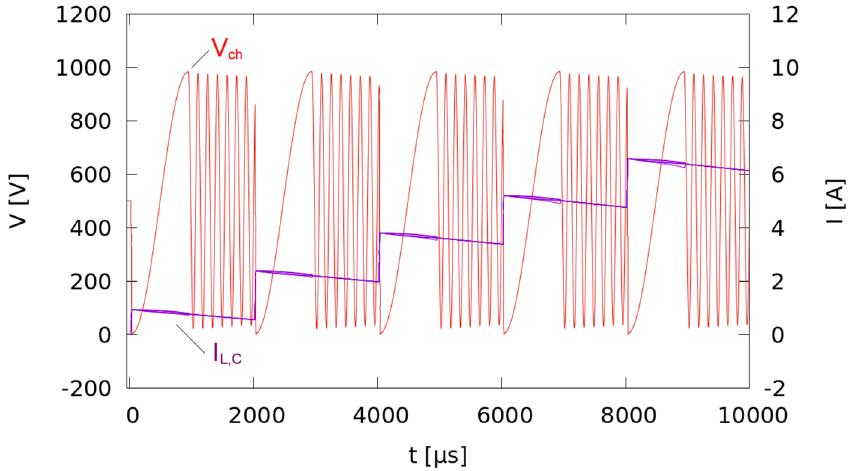
Figure 8. Simulated common-mode currents in the charging path (I L,C ) for the first five pulses with R D almost 0 Ohm. Thereby, I L,C is the superposition of the almost equal common-mode currents in all current-compensated chokes. V Ch is the charging voltage at the input terminal for charging the Marx generator.